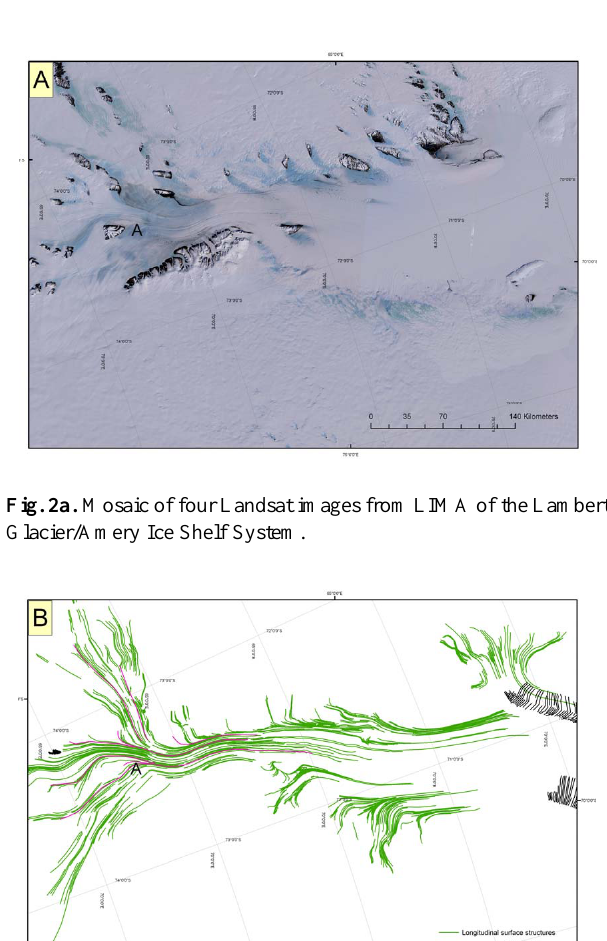
Figure 2B. Interpretation of longitudinal surface structures. Point A indicates development of longitudinal surface structures at the boundary between individual flow units.